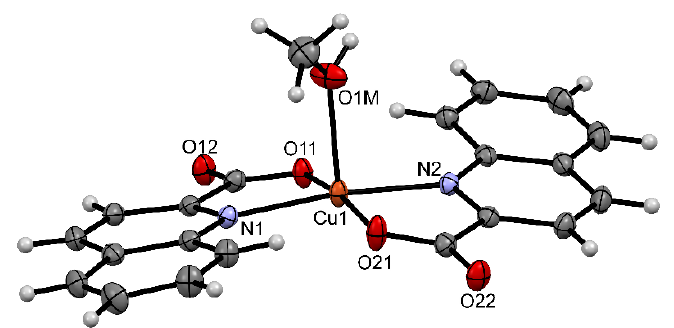
Figure 1. ORTEP drawing of [Cu(quin) 2 (CH 3 OH)], a complex molecule of 1 . Displacement ellipsoids are drawn at the 50% probability level. Hydrogen atoms are shown as spheres of arbitrary radii.